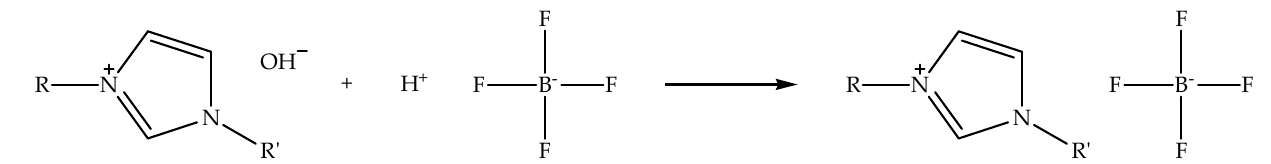
Figure 4. Schematic of the neutralization of alkylimidazolium hydroxide with tetrafluoroboric acid to prepare alkylimid- azolium tetrafluoroborate ionic liquid.